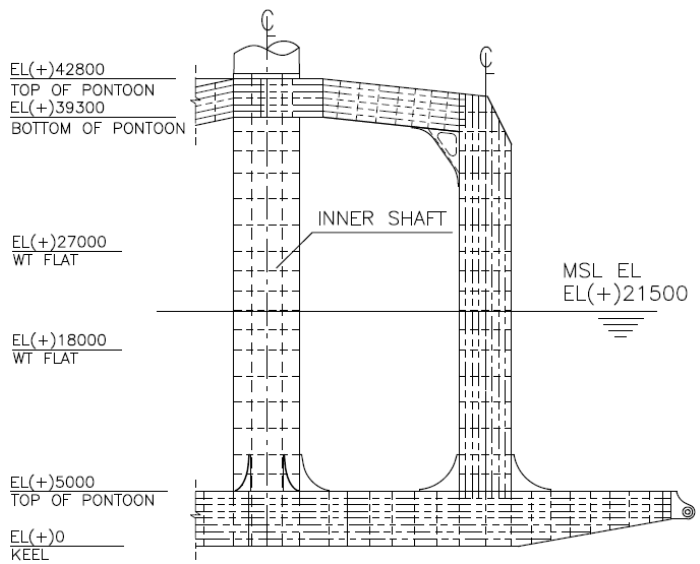
Figure 7. Structural layout of the WindStar